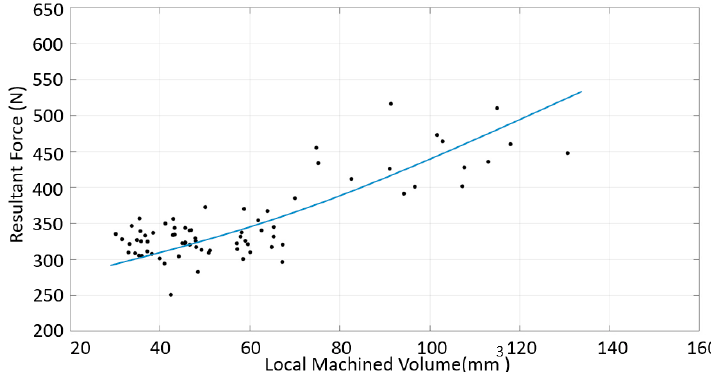
Figure 16. Resultant force vs. volume for the CRS material, down ‐ milling cases.